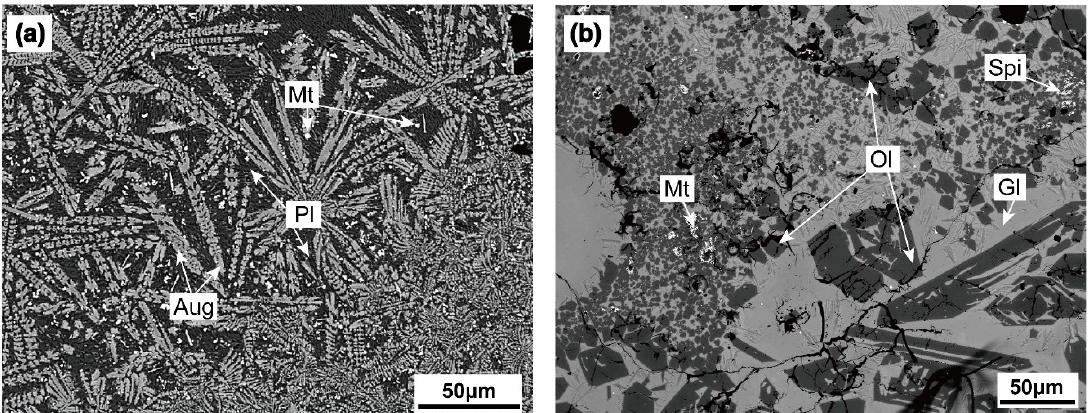
Figure 1. Back-scatter electron (BSE) images of the synthetic ( a ) komatiite and ( b ) basalt before experiments, as revealed by field emission–electron probe microanalyzer (FE-EPMA). ( a ) The dark gray strip-shaped structure is composed of plagioclase, while the light gray structure that spreads to fill the space is augite. Therefore, the strip-shaped structure in which the space between the plagioclase constituting the matrix is filled with pyroxene, called the intersertal texture, a peculiar basalt structure. ( b ) The dark gray strip-shaped structure is composed of olivine (spinifex texture), while the light gray structure that spread to fill the space is glass. Abbreviations: Spi—Cr spinel; Pl—plagioclase; Ol—olivine; Mt—magnetite; Aug—augite; Gl—glass. Table 2. Representative compositions of minerals (wt.%) in synthetic basalt and komatiite as determined using EPMA.